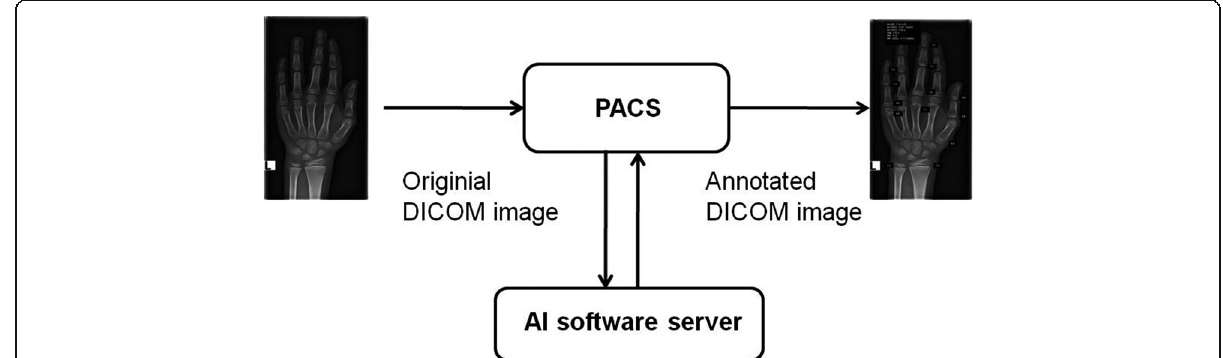
Fig. 2 Workflow of the evaluated software BoneXpert version 2.1. After sending the radiograph in DICOM (Digital Imaging and Communications in Medicine) format to the AI (artificial intelligence) software server, the software calculates the bone age of 13 bones (radius, ulna, and 11 short bones in fingers 1, 3, and 5) by application of active appearance models, which have learned the regular shape and density distribution of each analysed bone. After this analysis, the annotated DICOM image is sent back automatically to the PACS (Picture Archiving and Communication System). AI Artificial intelligence, DICOM Digital Imaging and Communications in Medicine, PACS Picture Archiving and Communication System